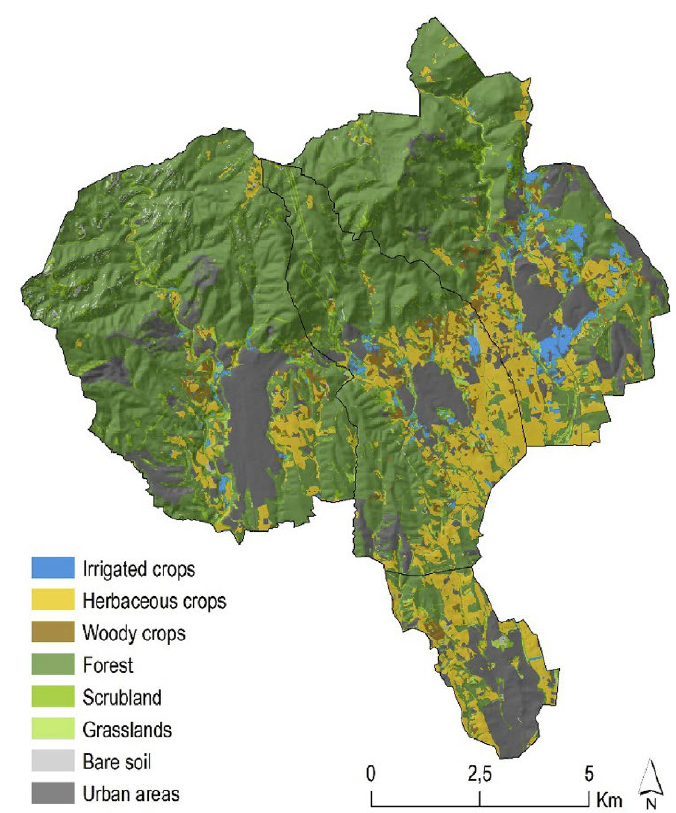
Figure 2. Land-use map for the Vallès case study in 2009. Source: Our own, adapted from the CREAF 4th edition of the soil cover map of Catalonia.